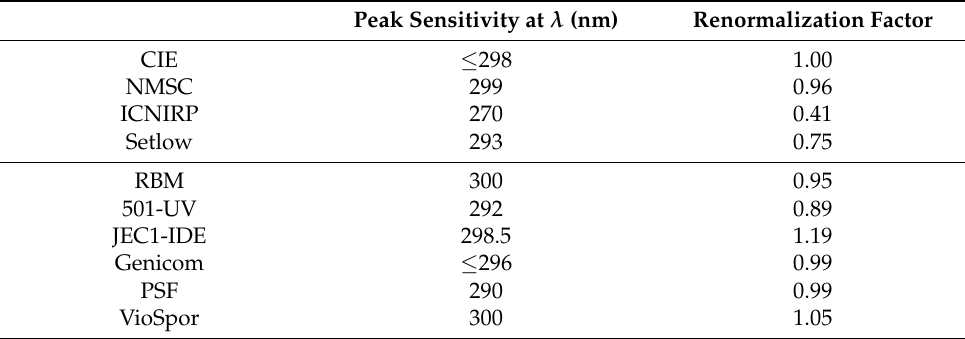
Table 2. Factors for a renormalization of all action spectra to the value at 297 nm. Peak Sensitivity at λ